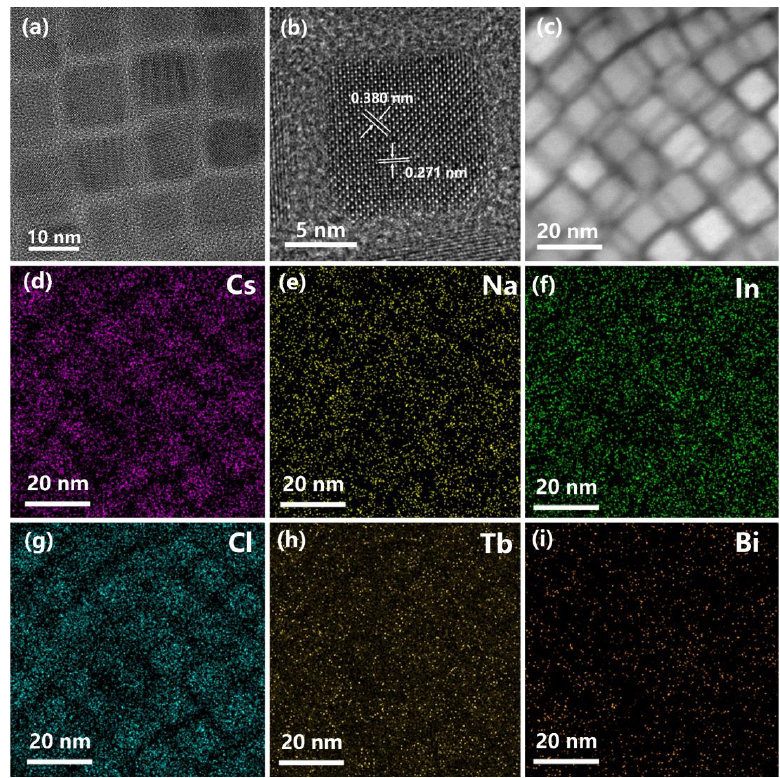
Figure 4. ( a ) TEM, ( b ) HRTEM, ( c ) high-angle annular dark field (HAADF) images of the Tb 3+ -Bi 3+ - co-doped Cs 2 NaInCl 6 NCs. ( d – i ) EDS elemental mappings of Cs, Na, In, Cl, Tb, and Bi localized in the Tb 3+ -Bi 3+ -co-doped Cs 2 NaInCl 6 NCs.